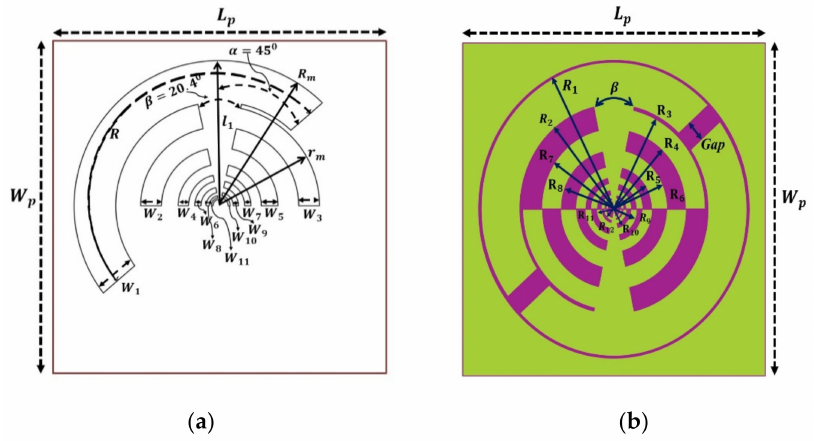
Figure 4. Geometry of the LP antenna, ( a ) detailed view of the single-sided structure, ( b ) complete design with dimensional